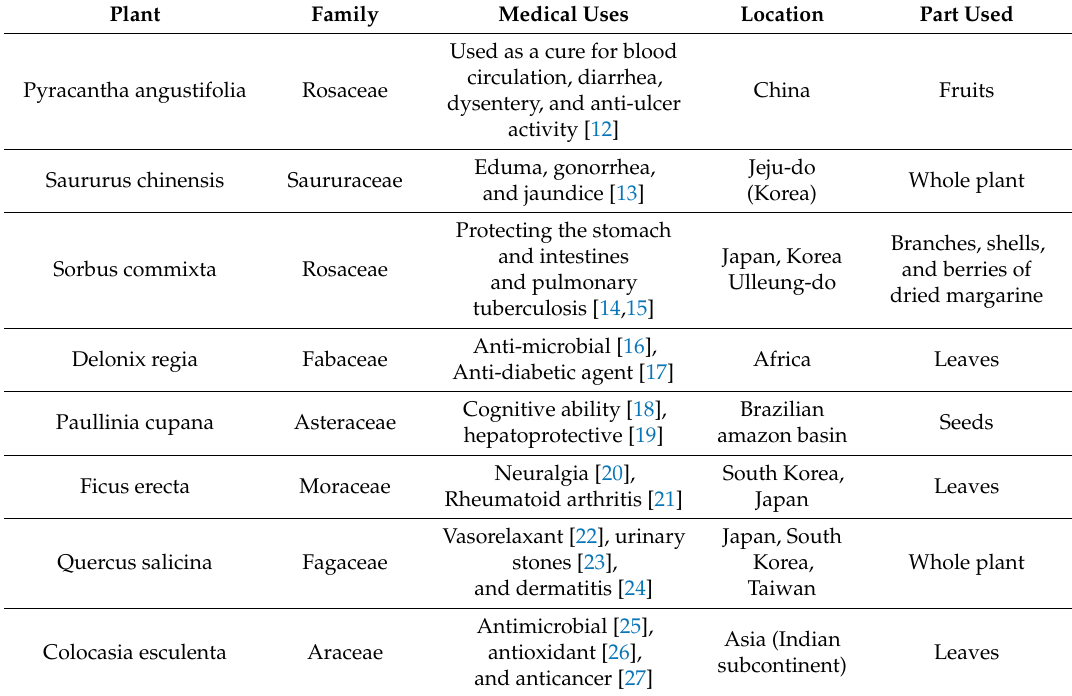
Table 1. Overview of eight plant extracts, including their medicinal uses and growing location details. Plant Medical